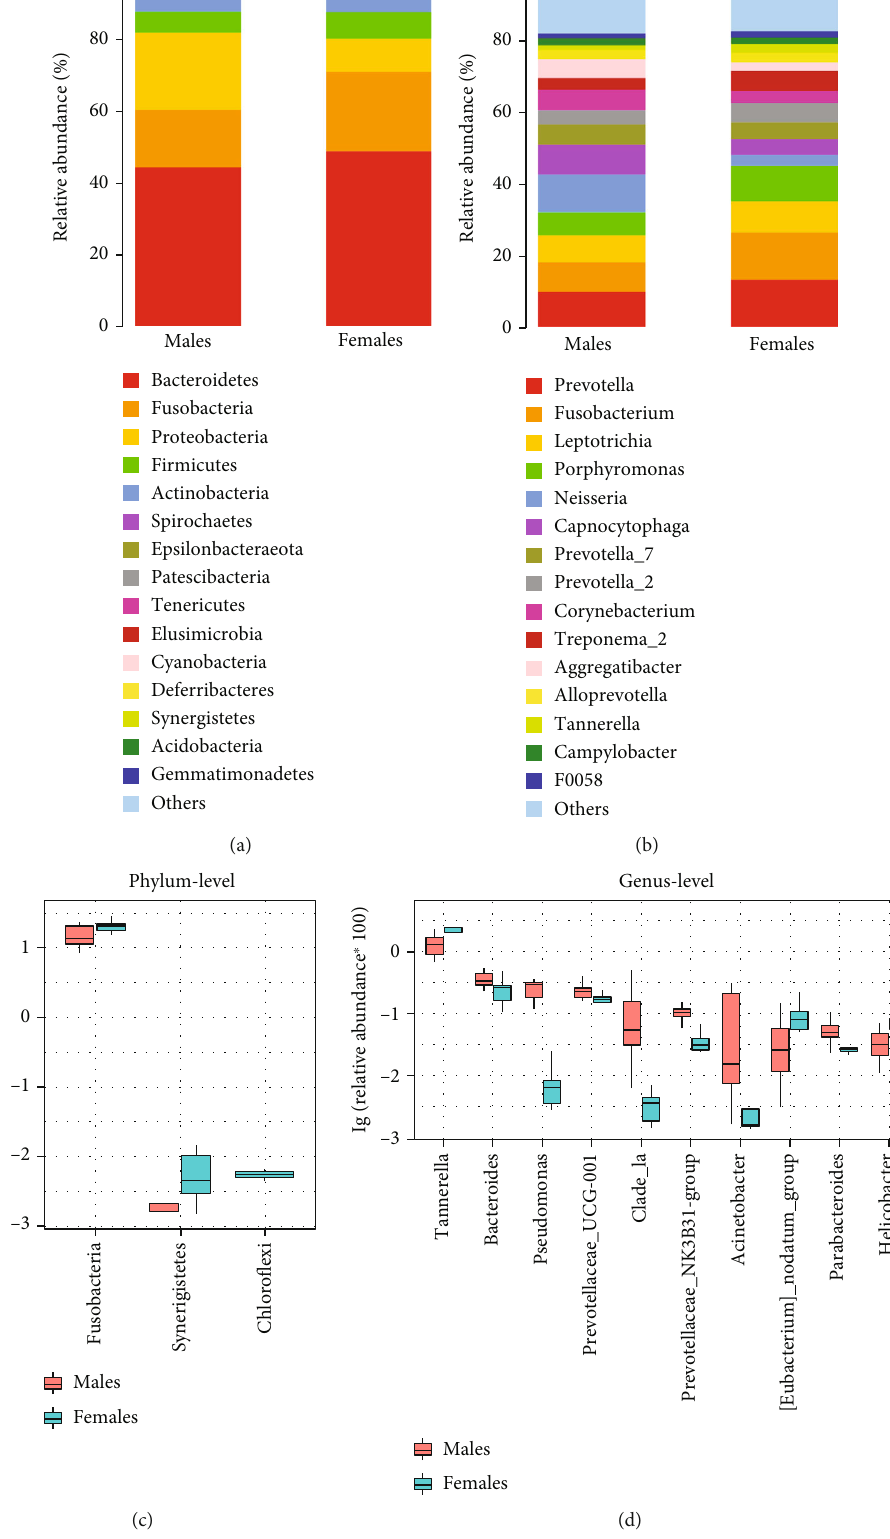
Figure 2: The oral microbiome composition of young male and female patients with severe and advanced periodontitis. (a) Phylum level composition. (b) Genus level composition. Species di ff erence analysis between males and females by the Kruskal-Wallis test at the level of the (c) phylum and (d)